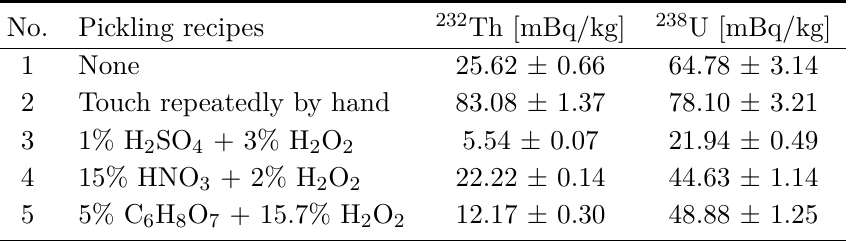
Table 3. Investigation of pickling recipes to remove 238 U and 232 Th on copper surface. The results show the relative 238 U and 232 Th change with dissolve a skin layer of copper.